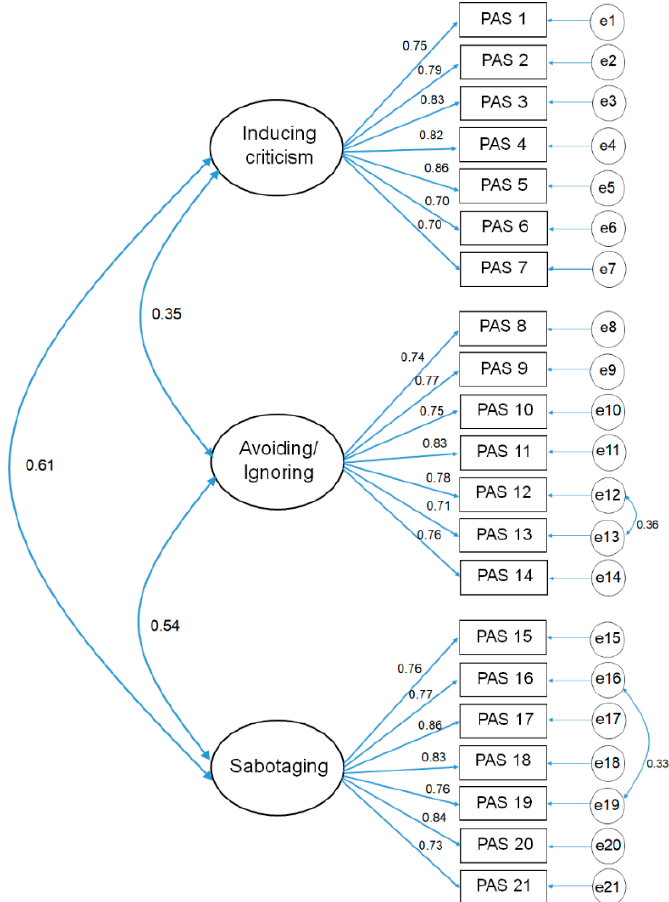
Figure 1. Construct model of the PAS, three-factor model.